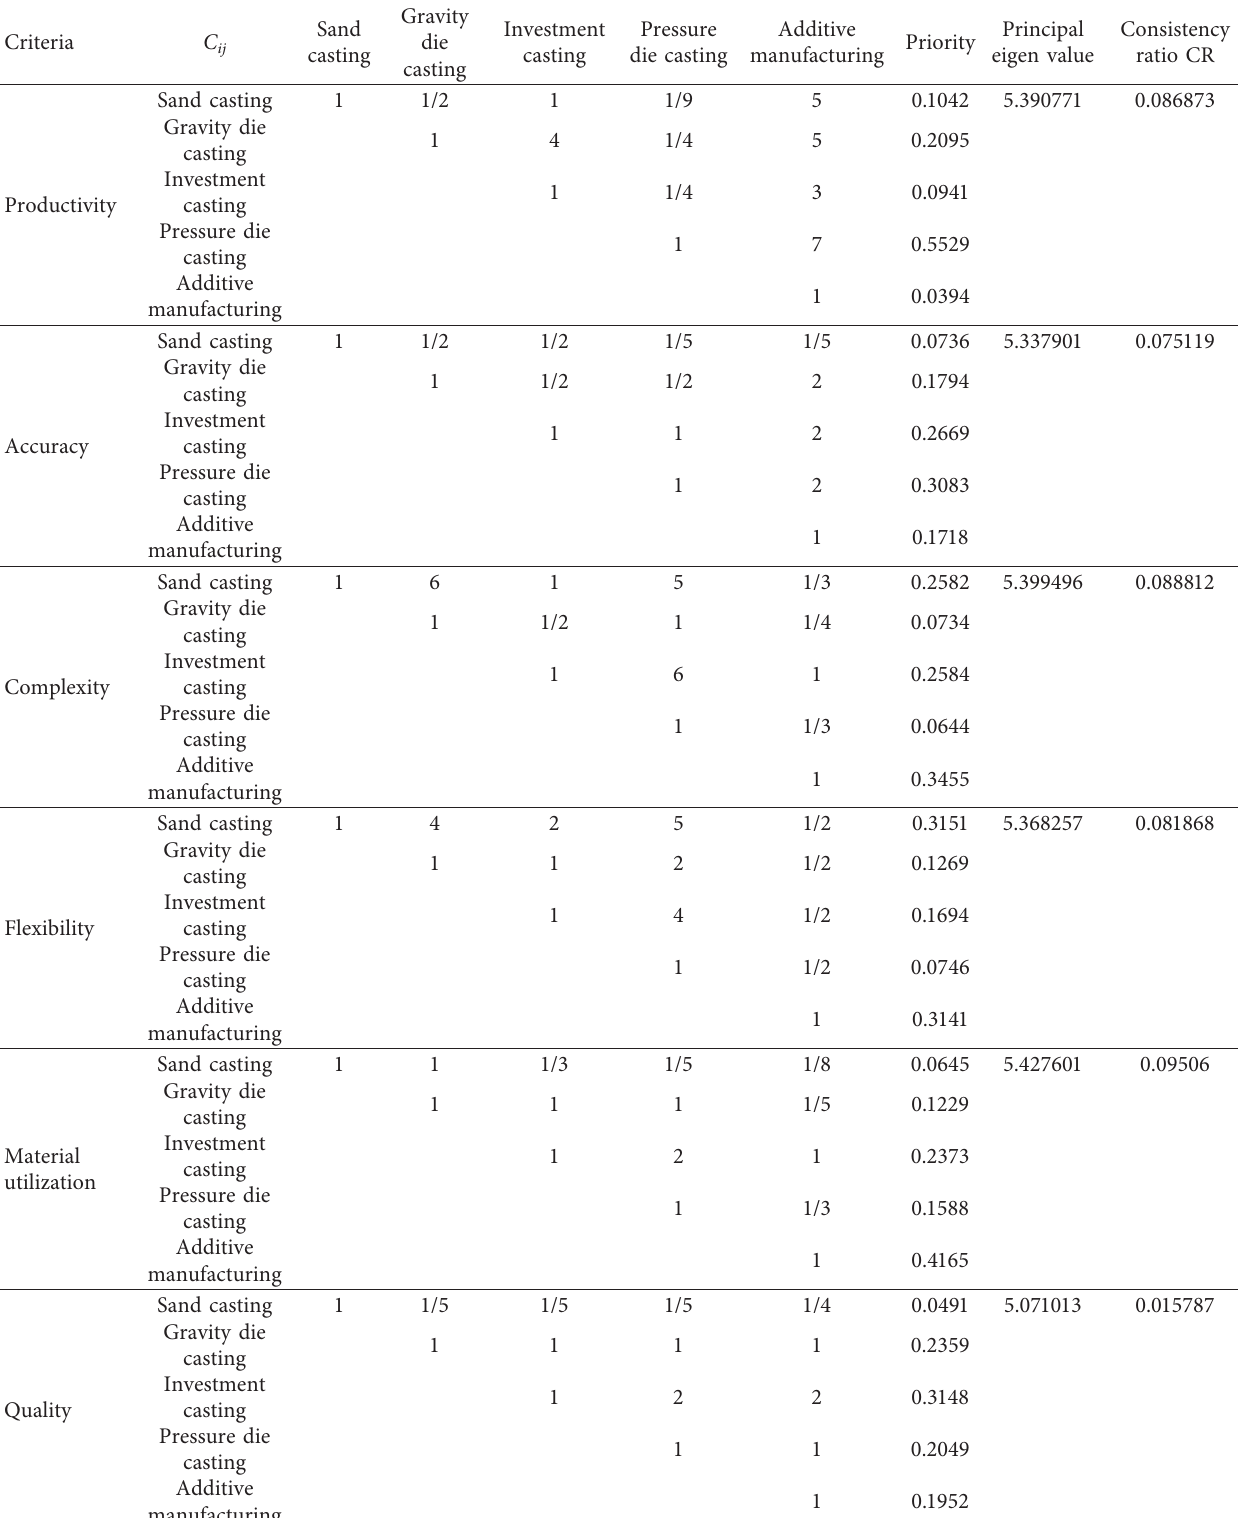
Table 3: The original data of rating manufacturing process in the